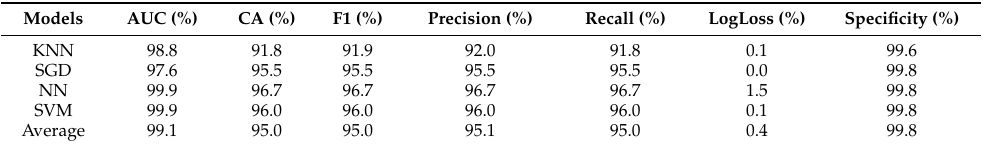
Table 2. K-Means evaluation results for fused datasets (F1) using data mining models such as KNN, SGD, NN, and SVM.